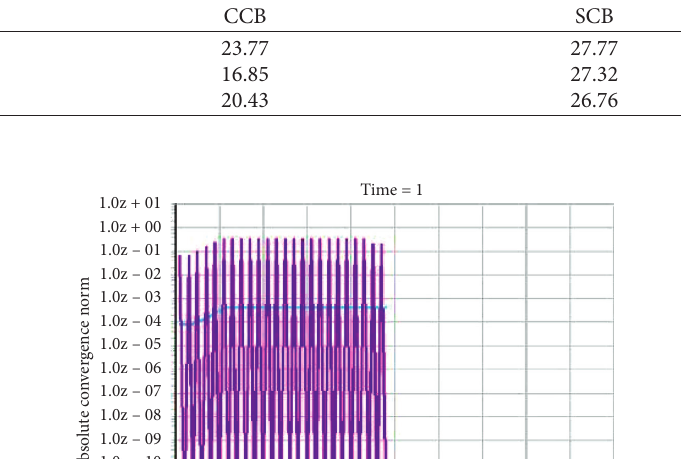
Table 9: Cracking loads of the single-span composite T-shaped beams (kN · m).